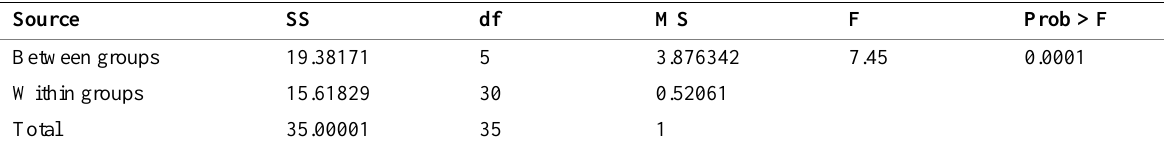
Table 6: One way Analysis of Variance